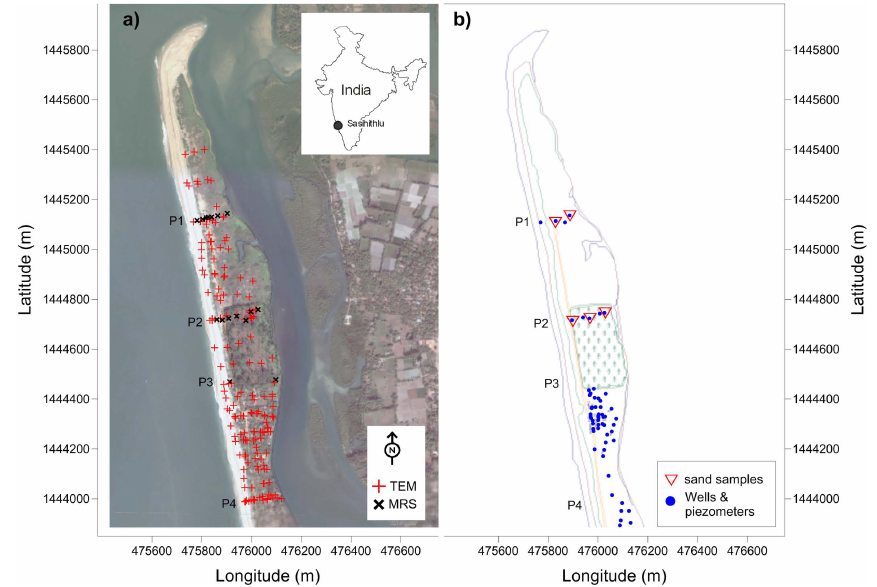
Fig. 3. Location of Sasihithlu barrier and measurements. (a) Geophysical measurements (including pre and post monsoon time lapse). (b) Hydrological